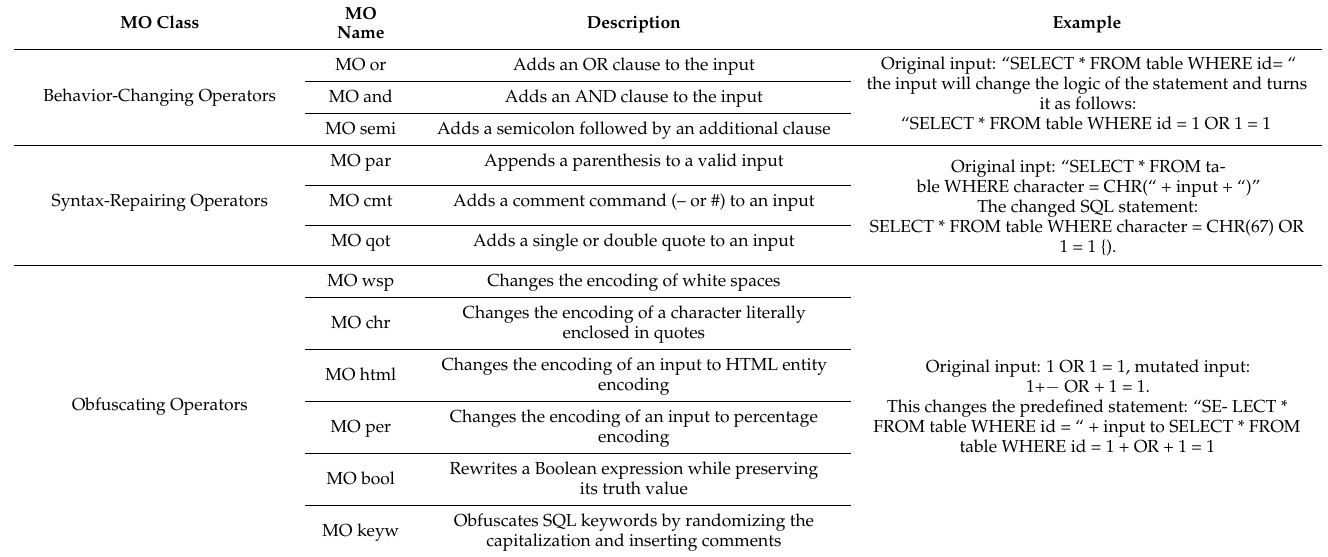
Table 2. Summary of mutation operators (adopted from